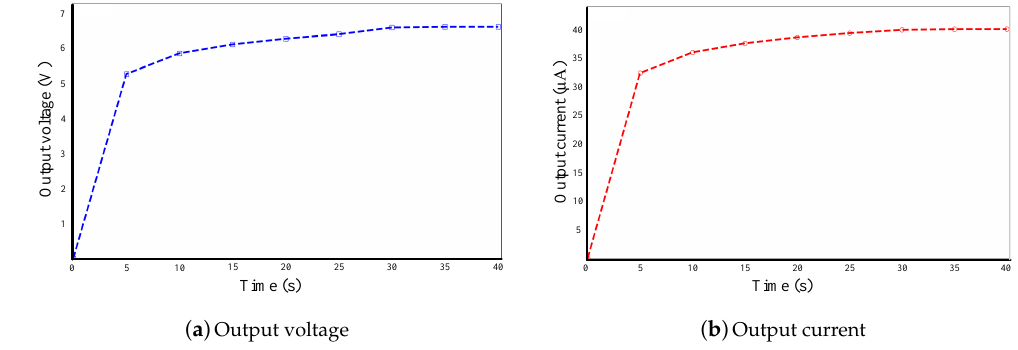
Figure 10. DC output values of the harvesting RF energy.